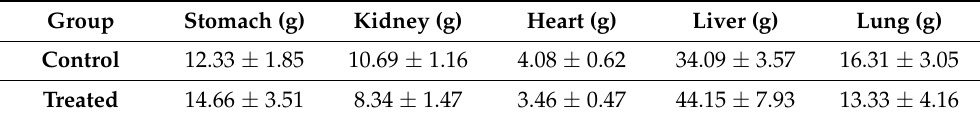
Table 8. Vital organs weight difference between both groups ( n =